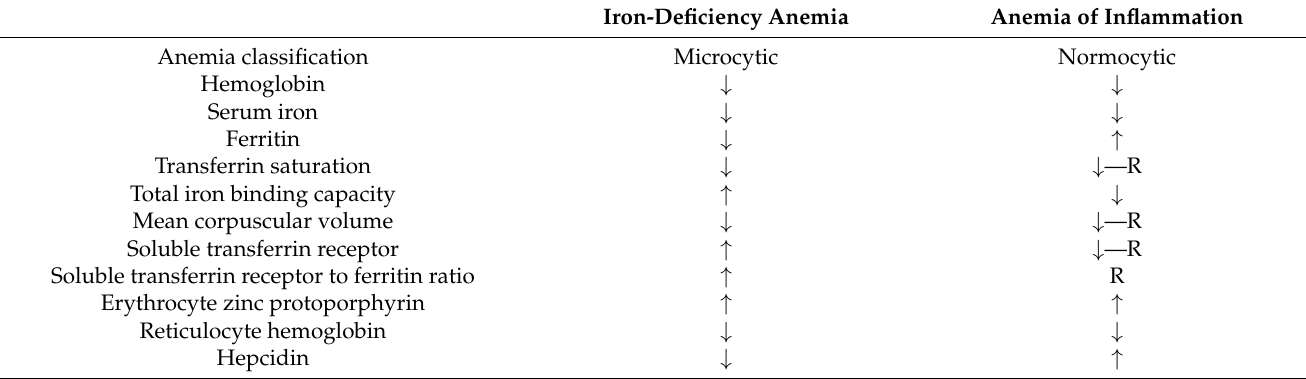
Table 1. Contrasting diagnosis of iron-deficiency anemia and anemia of inflammation *. Iron-Deficiency Anemia Anemia of Inflammation Anemia classification Microcytic Normocytic Hemoglobin